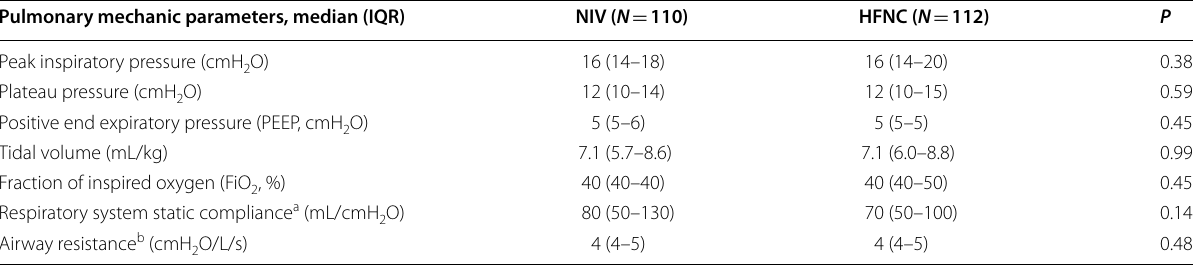
Table 1 Pulmonary mechanic parameters of the patients